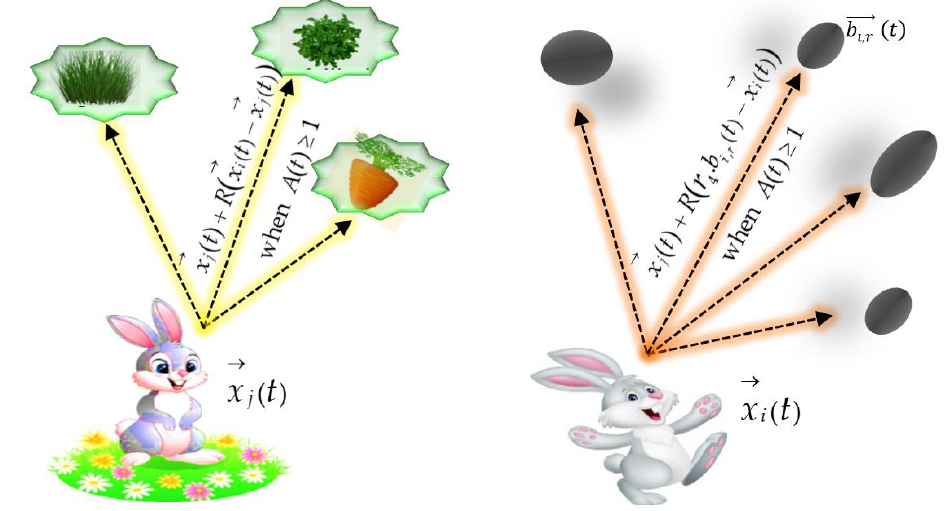
Figure 6. Search mechanism based on the energy factor.